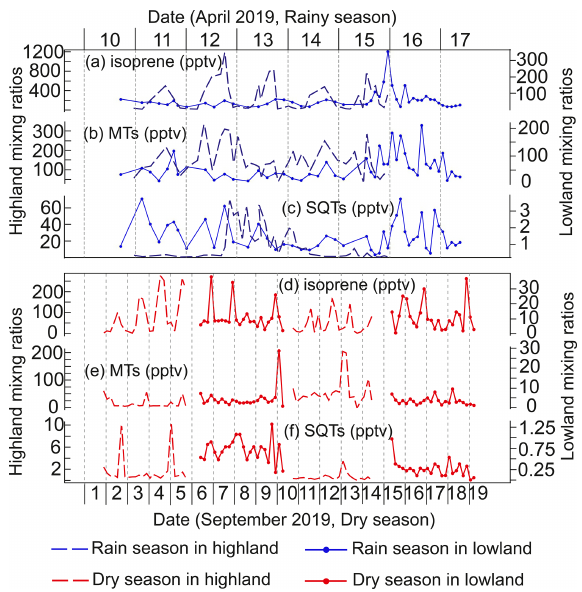
Figure A3. The temporal variability in biogenic volatile organic compound mixing ratios in the highland and lowland ecosystems during the rainy and dry seasons. (a, d) Isoprene. (b, e) Monoter- penoids (MTs). (c, f) Sesquiterpenes (SQTs).